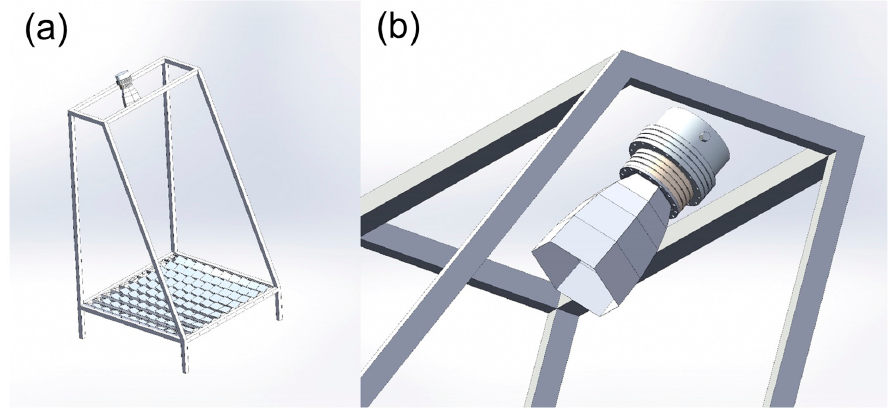
Figure 2. Renderings of: ( a ) the assembly of the BAF concentrator and the converter; ( b ) the detail of the receiver equipped with the secondary concentrator mirror